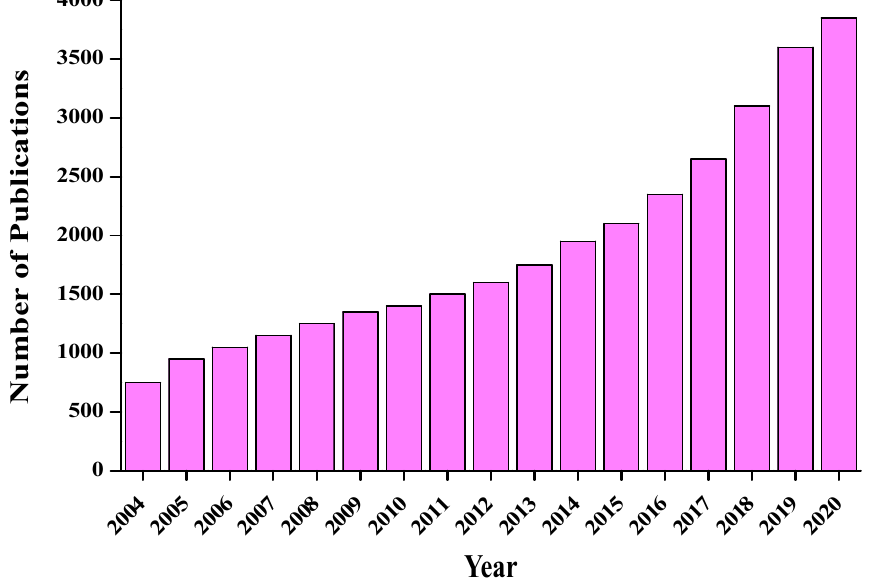
Figure 4. The number of publications related to CDs. A surge of interest in recent years is observed.